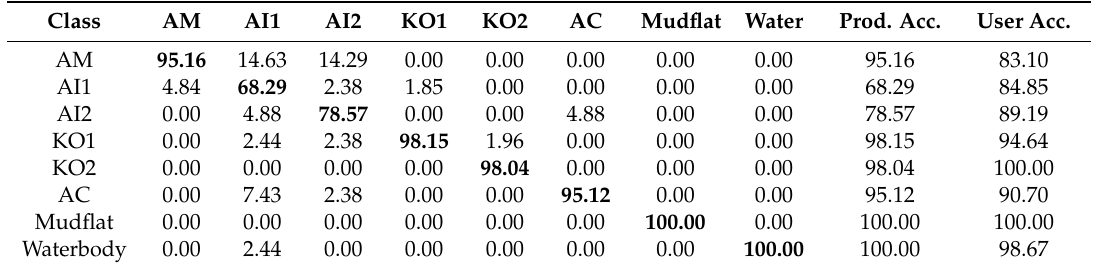
Table 6. Confusion matrix calculated from SVM + OSTD classification results.